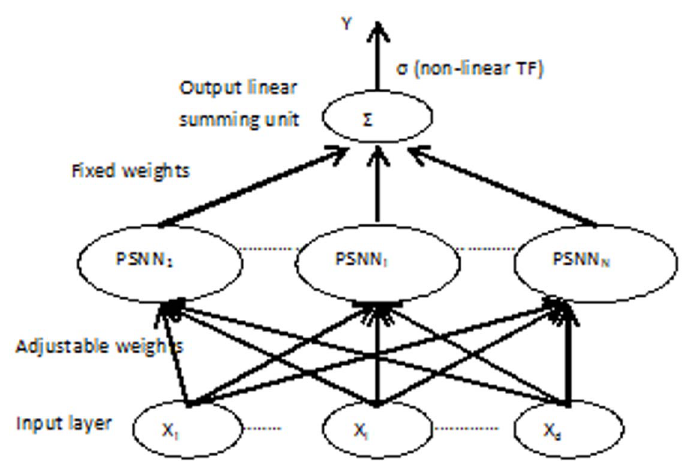
Figure 3. Ridge Polynomial Neural Network of N-th.